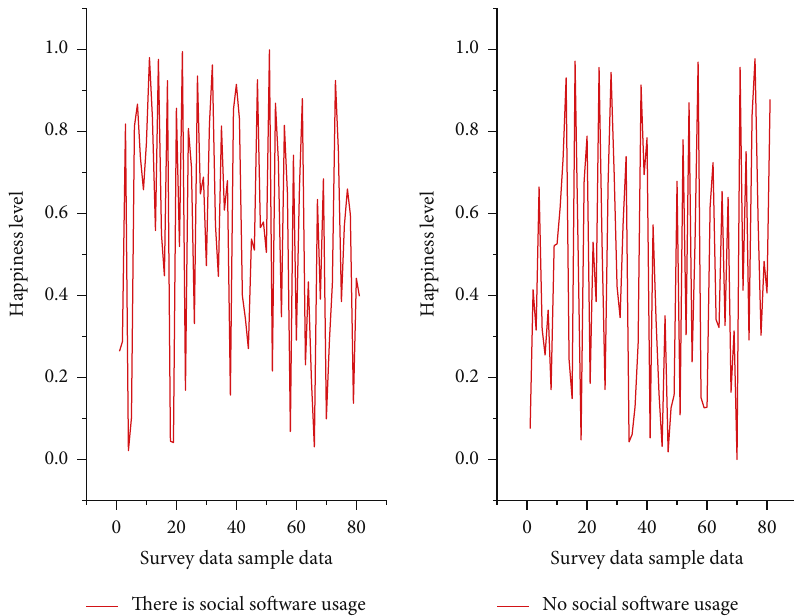
Figure 7: The presence or absence of sharing behavior on mobile social media on mental